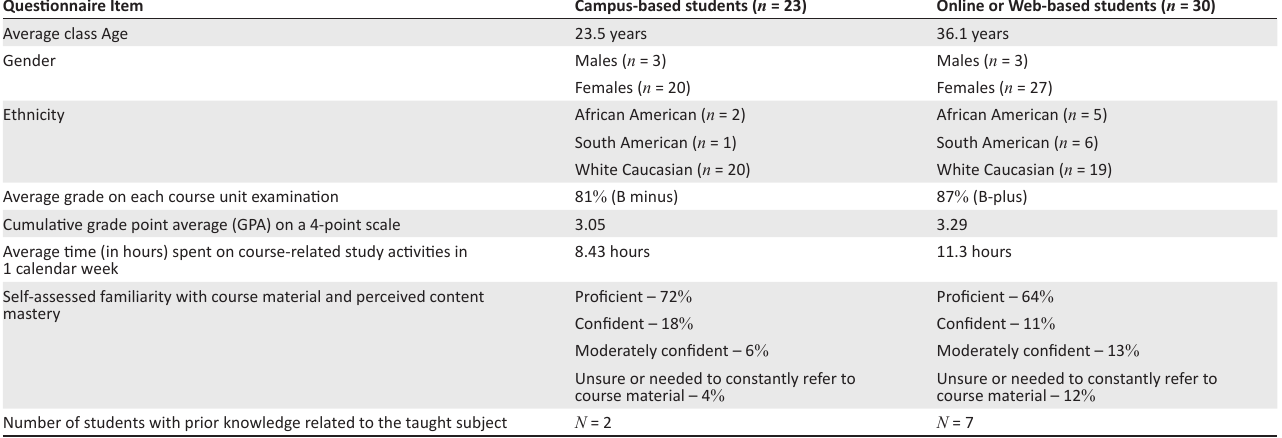
TABLE 1: Summary of student data from the student performance-recording tool. Questionnaire